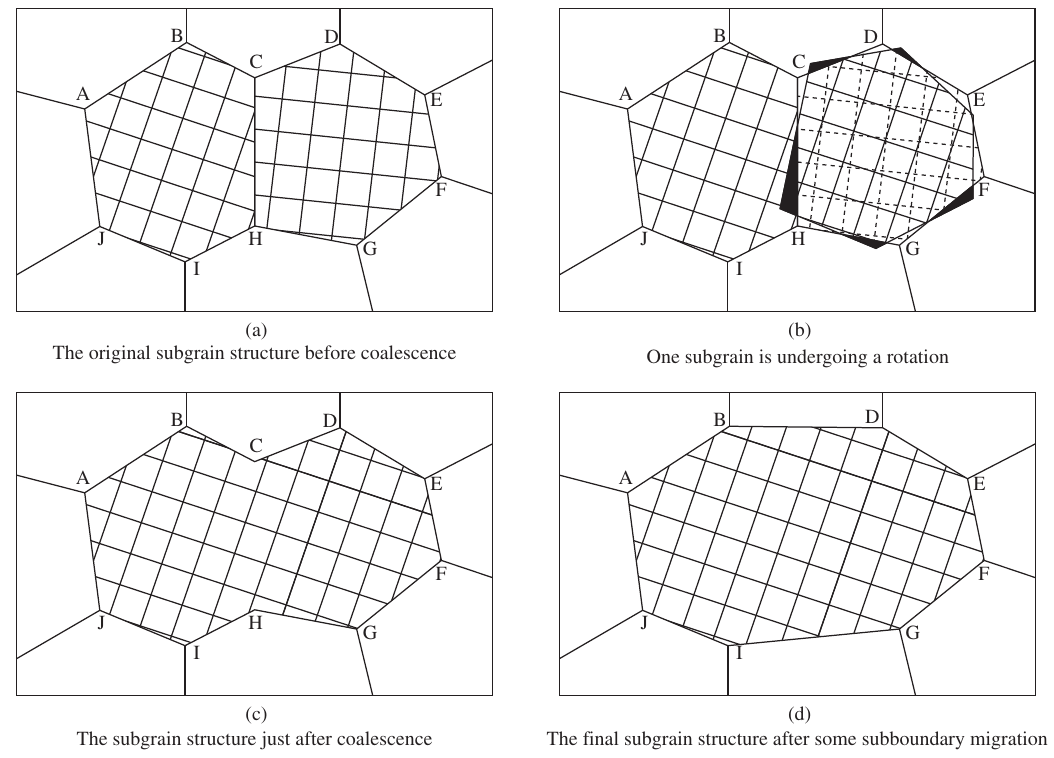
Figure 4. Coalescence of two subgrains by “rotation” of one of them: a) original structure prior to coalescence; b) rotation of the CDEFGH grain; c) subgrain structure subsequent to coalescence; and d) final structure after sub-boundaries migration 65 .